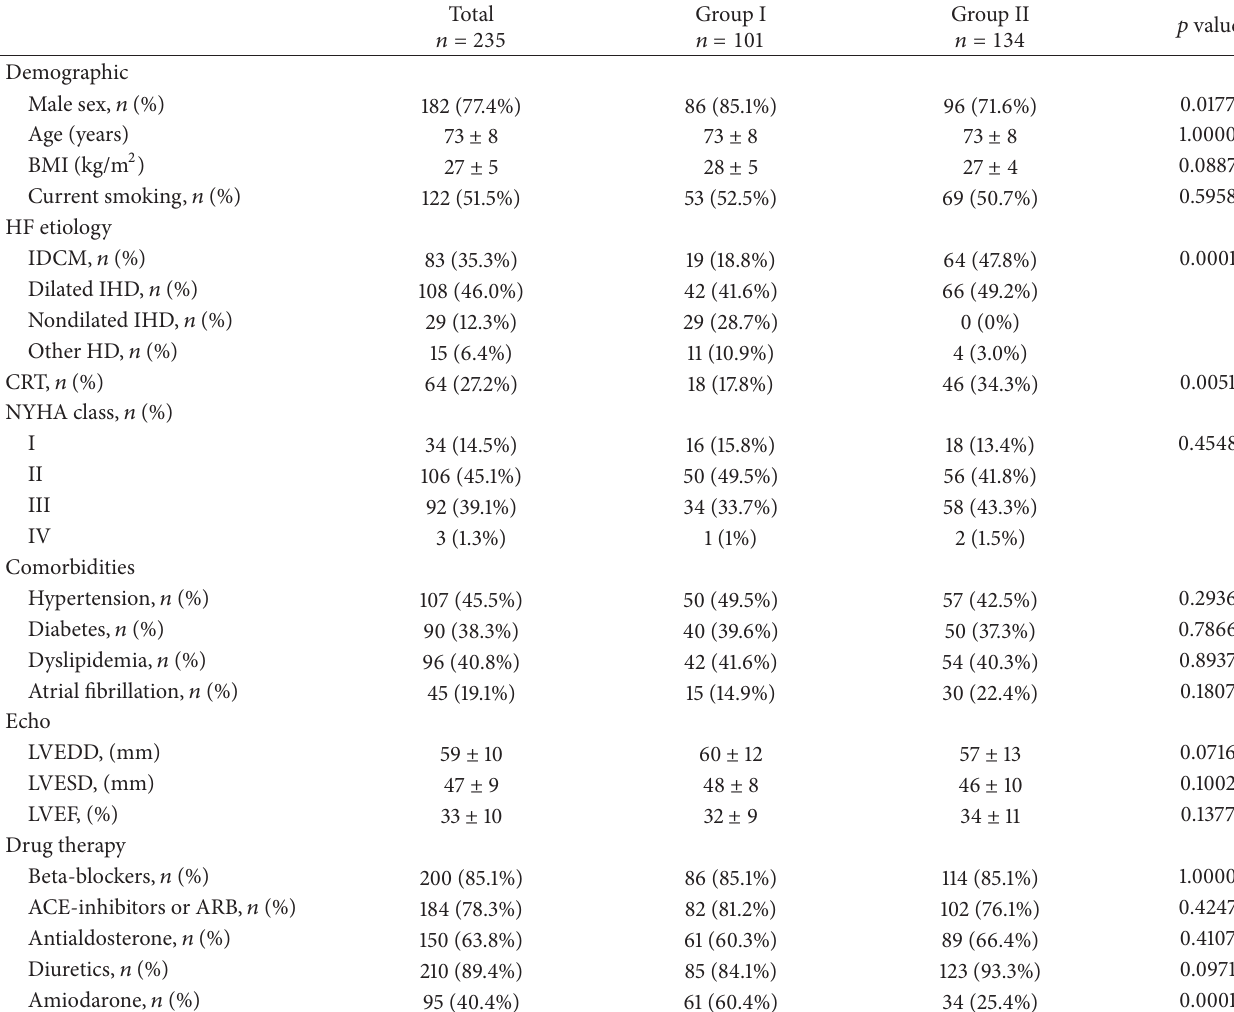
Table 2: Demographic data and clinical features of the study population according to arrhythmias